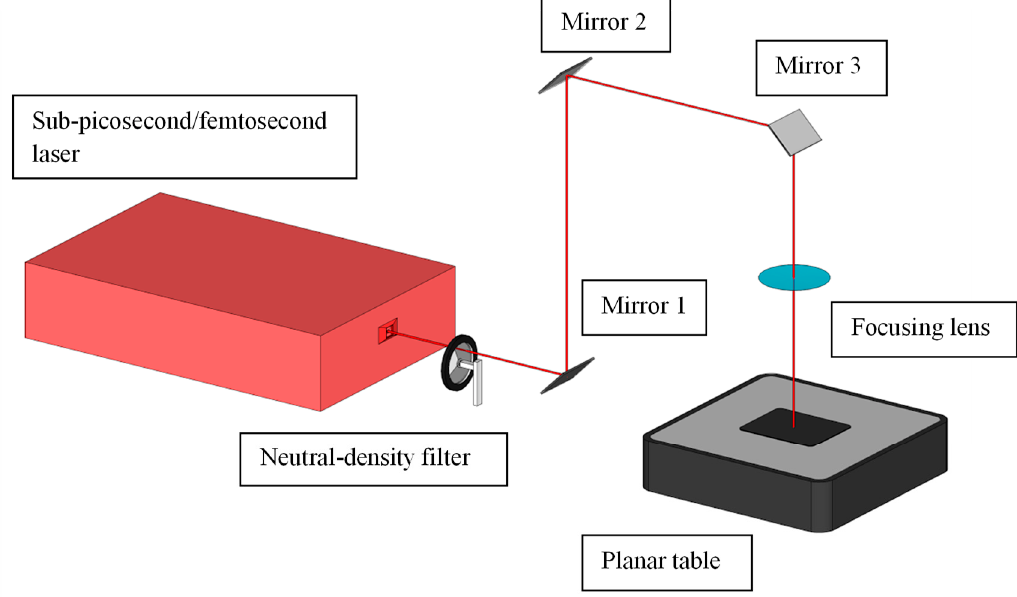
Figure 1. The experimental setup for ultrafast laser micromachining.